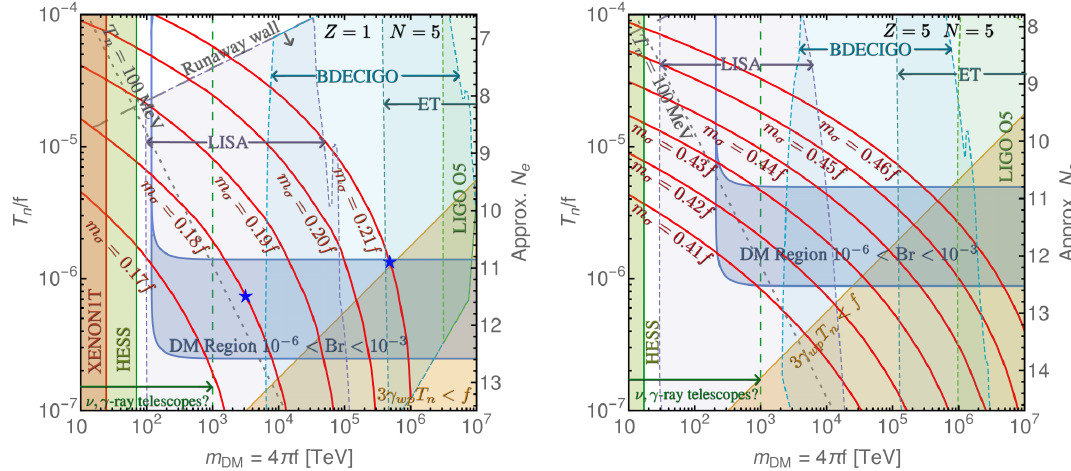
= 4 πf showing the required supercooling Figure 7 . Left: the parameter space for Z = 1 and m DM to match the relic abundance in the dark blue region (standard thermal freeze-out is recovered where the dark blue region morphs into a vertical line). The supercooling is achieved for m 0 . 2 f σ ∼ with the precise mass of the dilaton depending on the scale f . The red contours terminate when the universe becomes trapped in the metastable state. In the yellow region in the bottom-right corner the quarks are insufficiently energetic to enter the first bubble they encounter. The stars indicate two benchmark points for which we show the gravitational wave spectrum in the following section. Regions testable with LISA, BDECIGO, ET (SNR 10 4 ) and LIGO O5 (SNR 10) are FGL > FGL > shown. (The gap between LISA and ET closes for SNR = 10 2 .) The GW signal has only been FGL calculated in the runaway regime, so that it is inaccurate in the top-left corner. Current direct and indirect detection limits are shaded in red and green, respectively. The LZ reach is not indicated to avoid clutter, as it falls in the region already excluded by HESS. The presumed reach of future γ -ray telescopes to DM annihilations with cross sections close to the unitarity bound, as predicted in our model, is indicated with a dashed green line. Right: the parameter space for Z = 5 . The required supercooling is achieved for m 0 . 45 f . The number of e-folds has a small log σ ∼